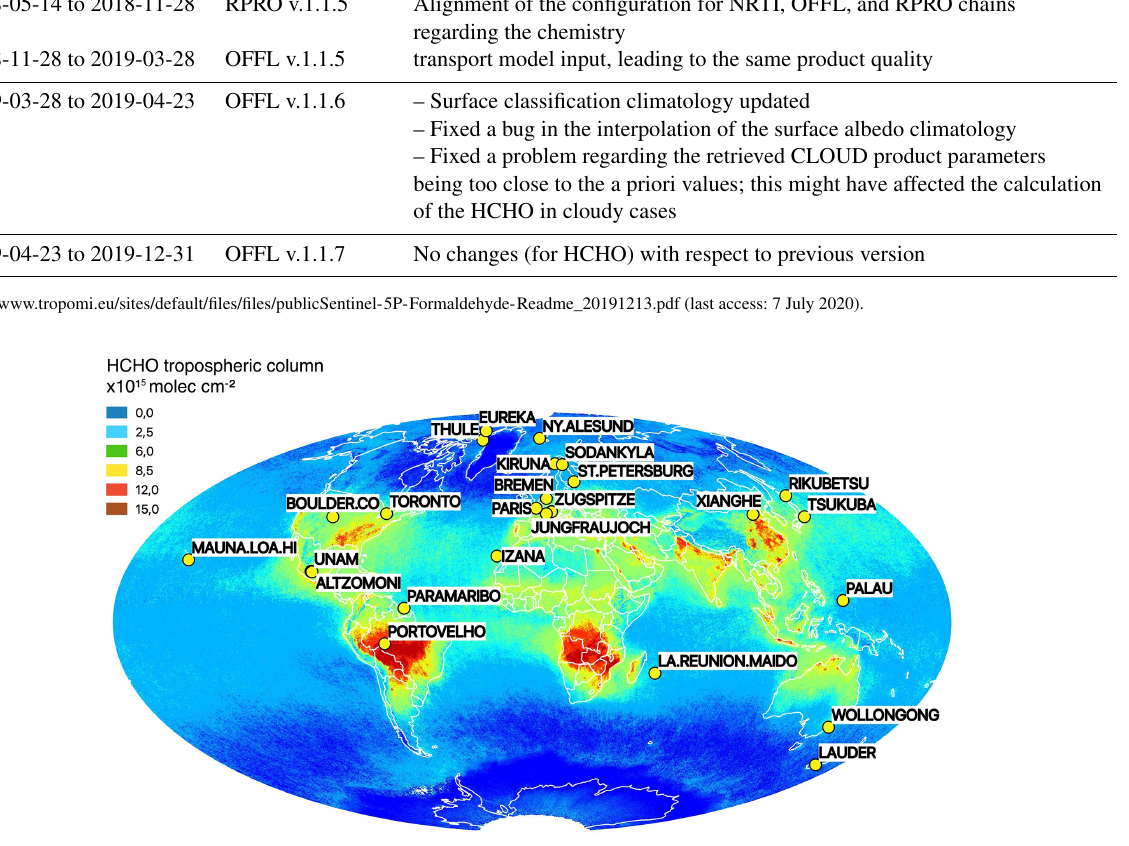
Figure 1. Network of ground-based FTIR stations providing HCHO total column data. The background is the September 2018 monthly mean of TROPOMI HCHO tropospheric columns, averaged on a 0 . 2 ◦ × 0 . 2 ◦ grid using the HARP tool v.1.5 (https://atmospherictoolbox.org, last access: 7 July